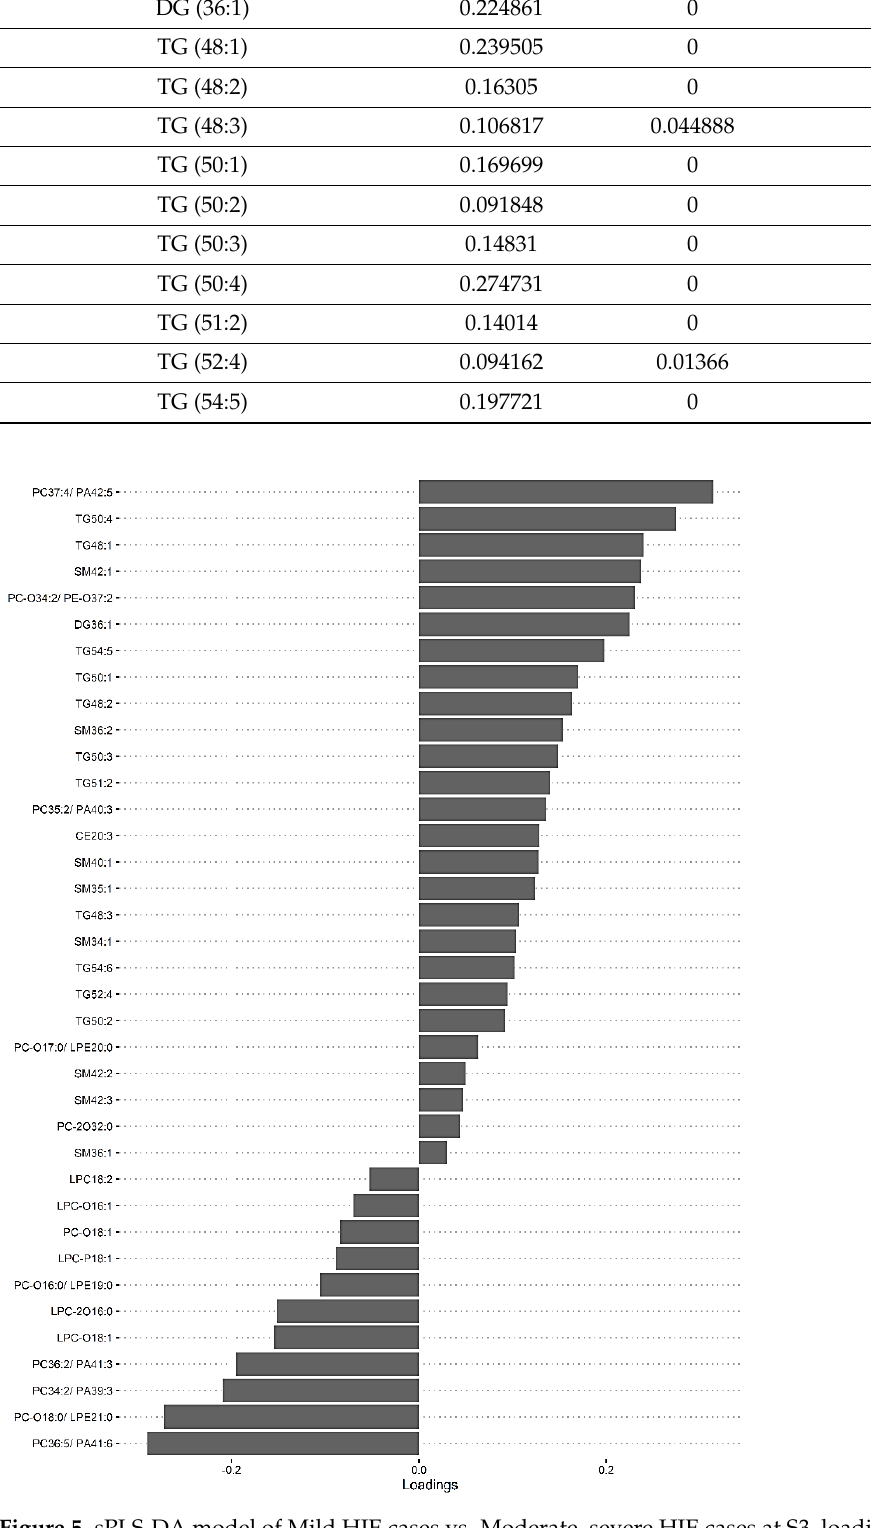
Figure 5. sPLS-DA model of Mild HIE cases vs. Moderate–severe HIE cases at S3, loadings plot of Component 1. Table 6. sPLS-DA loading values for Mild HIE cases vs. Moderate – severe HIE Cases at S3.